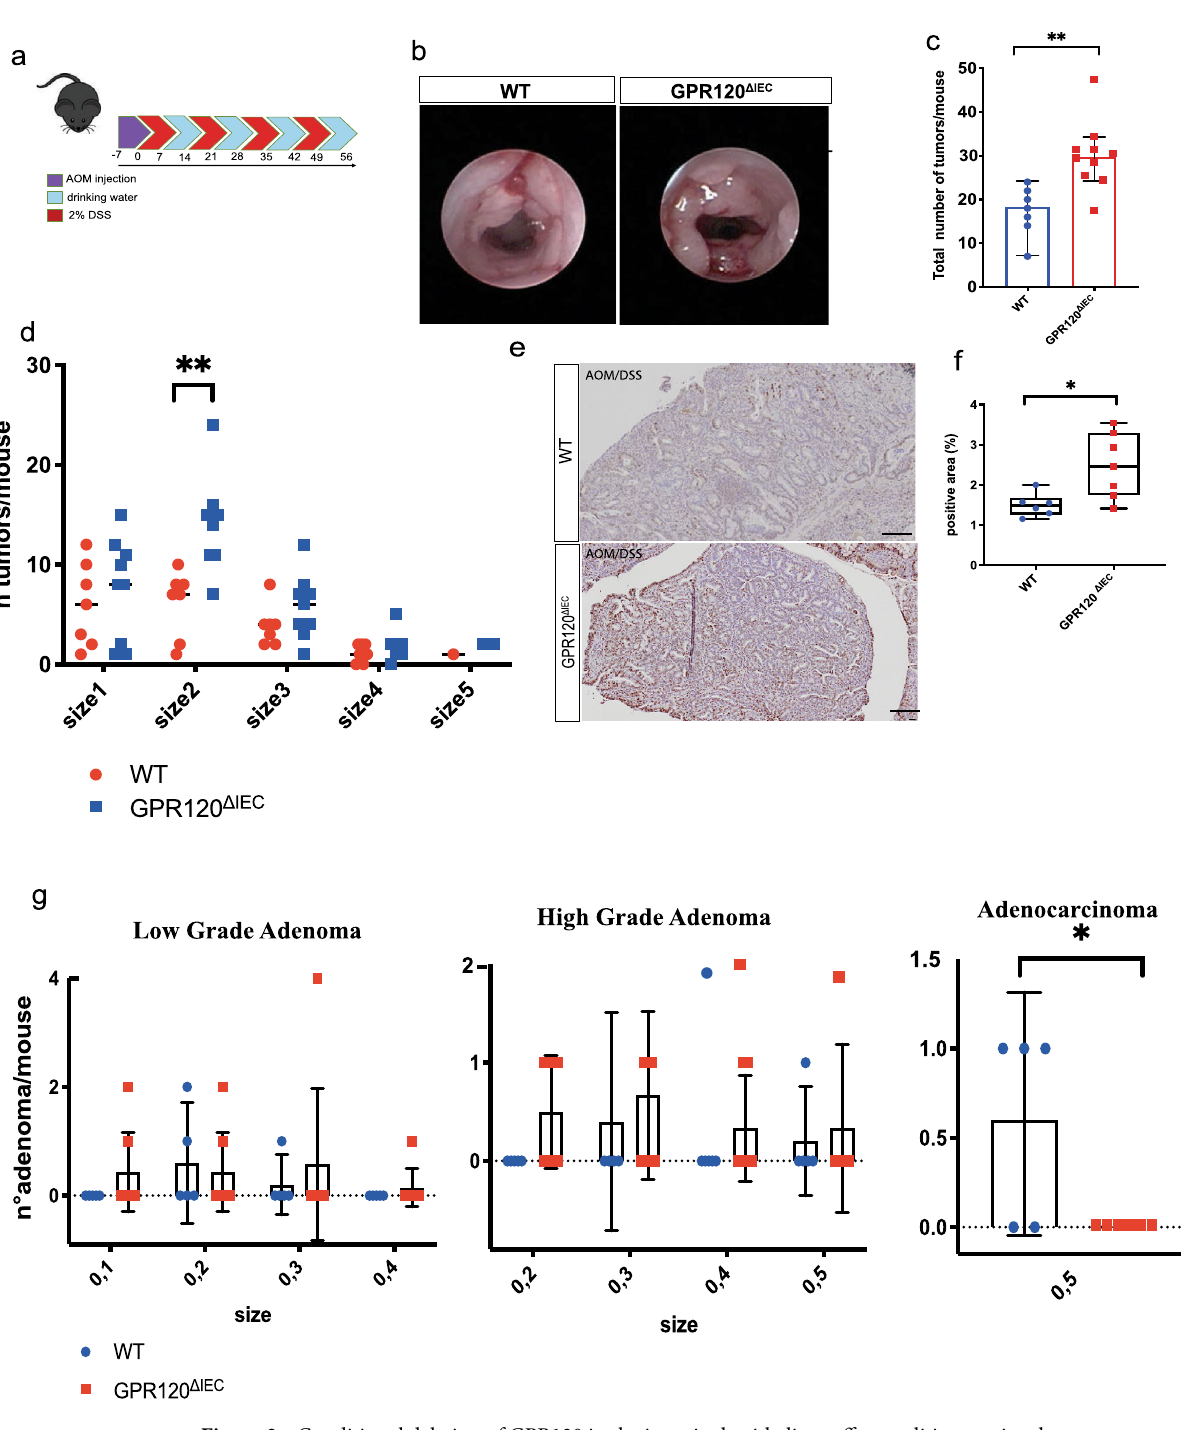
Figure 3. Conditional deletion of GPR120 in the intestinal epithelium affects colitis-associated cancer development. ( a ) GPR120 ΔIEC (n = 7) and WT (n = 7) mice were subjected to the AOM/DSS-induced model of CRC as schematize. ( b ) Representative endoscopic images showing mouse polyps at day 57. Tumor density ( c ) and size ( d ) assessed at day 57 by endoscopic scoring. The size depends upon the average of diameter: size 1 very small but detectable tumor, size 2 tumor covering up to one-eighth of colonic circumference, size 3 tumor covering up to one-fourth of the colonic circumference, size 4 tumor covering up to half of the colonic circumference, and size 5 tumor covering more than half of the colonic circumference. ( e, f ) Representative paraffin-embedded colon sections from tumor bearing GPR120 ΔIEC (n = 7) and WT (n = 7) mice stained for Ki67 ( e ) and relative quantification expressed as percentage of immune positive area ( f ). Magnification 20x. Scale bar: 100 μm. ( g ) Histological score quantifying Low grade (left panel), High grade (central panel) adenomas, and adenocarcinoma (right panel) on paraffin-embedded colon sections (n = 7 per group) stained with Hematoxylin & Eosin